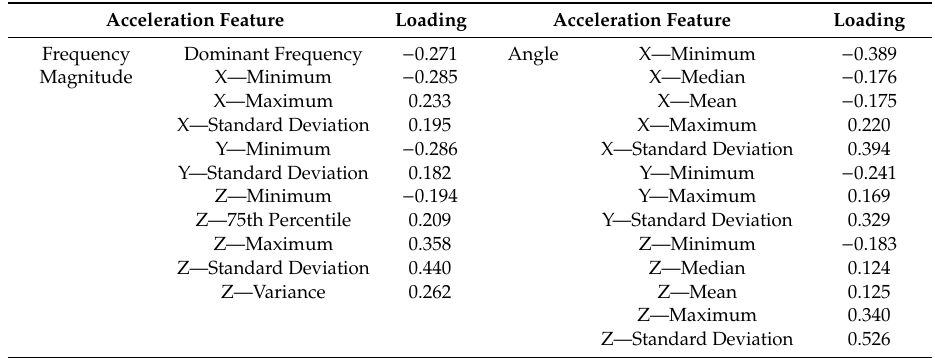
Table 2. Loading (Pearson’s correlation) on acceleration features included in the model (development